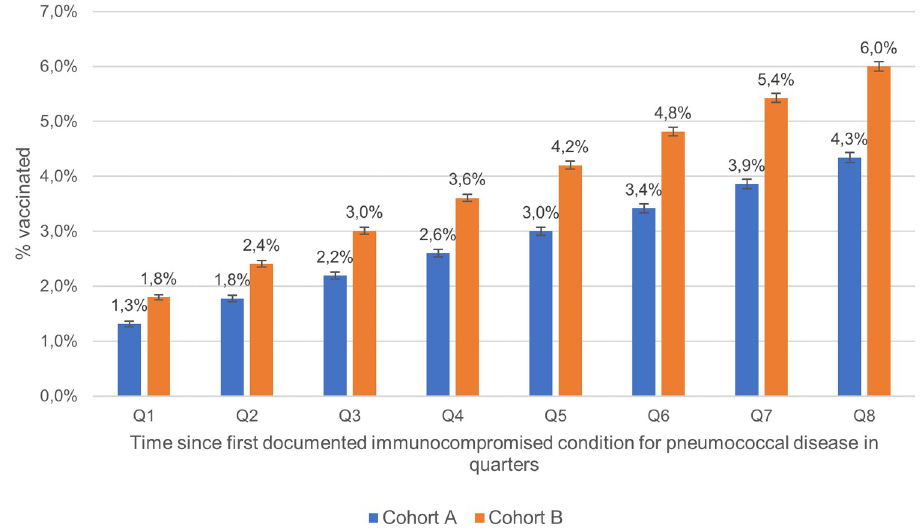
Fig 2. Cumulative pneumococcal vaccination rate within eight quarters after first documented immunocompromised condition by cohort.